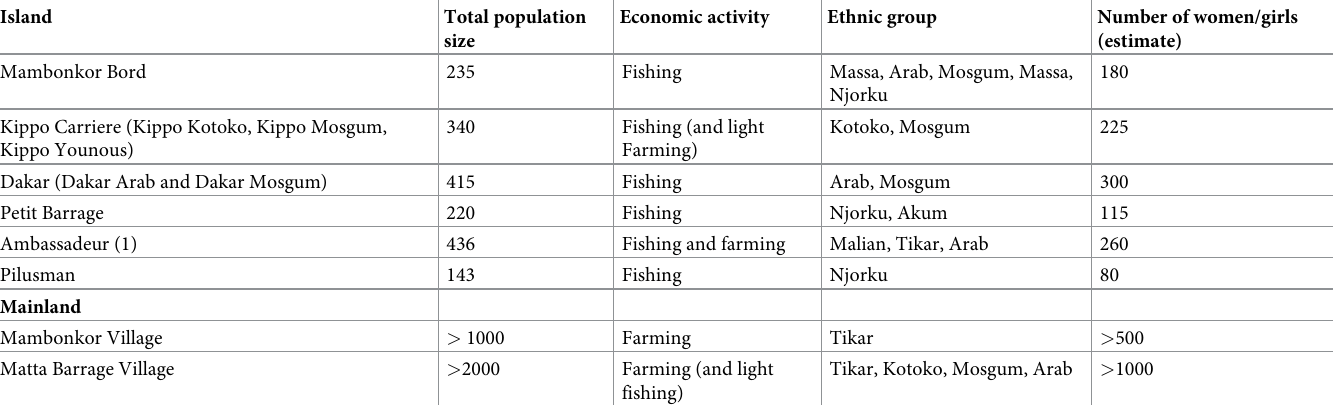
Table 1. Study site/population description (complemented with data from Malanteoun health district census, 2018–2020. S1